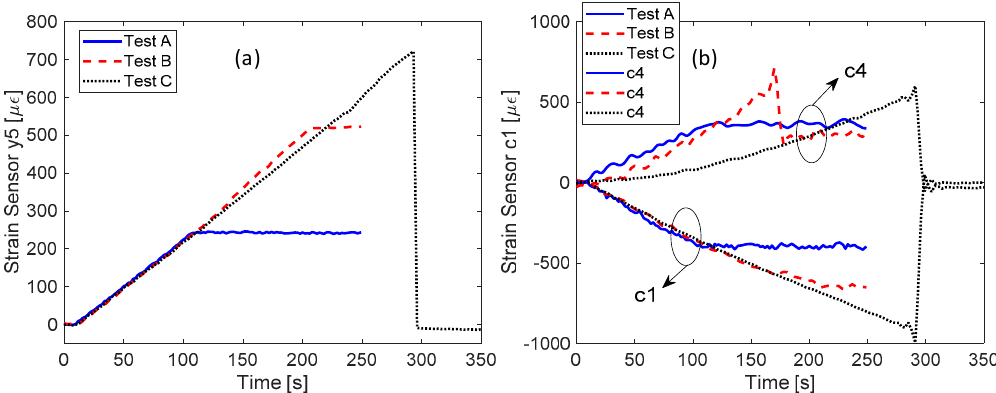
Figure 9. Comparison between the time responses in different test sections for the following sensors: ( a ) sensor Y 5 ; and ( b ) sensors C 1 and C 4 .